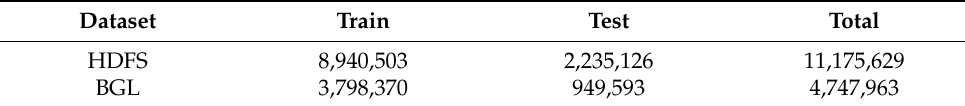
Table 3. Log datasets.